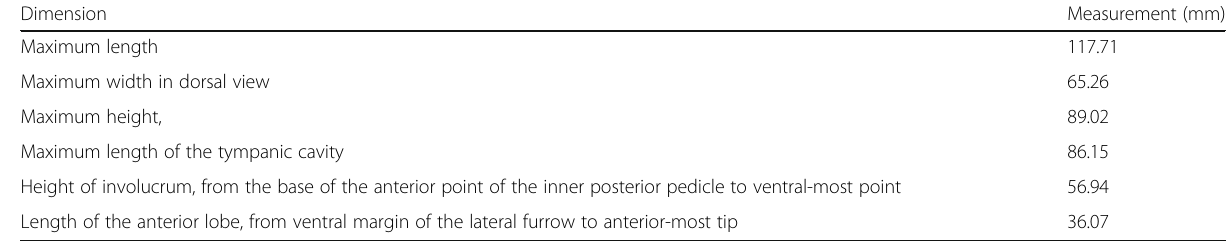
Table 1 Measurements (in mm) of the left tympanic bulla of Eubalaena sp., NTUM-VP